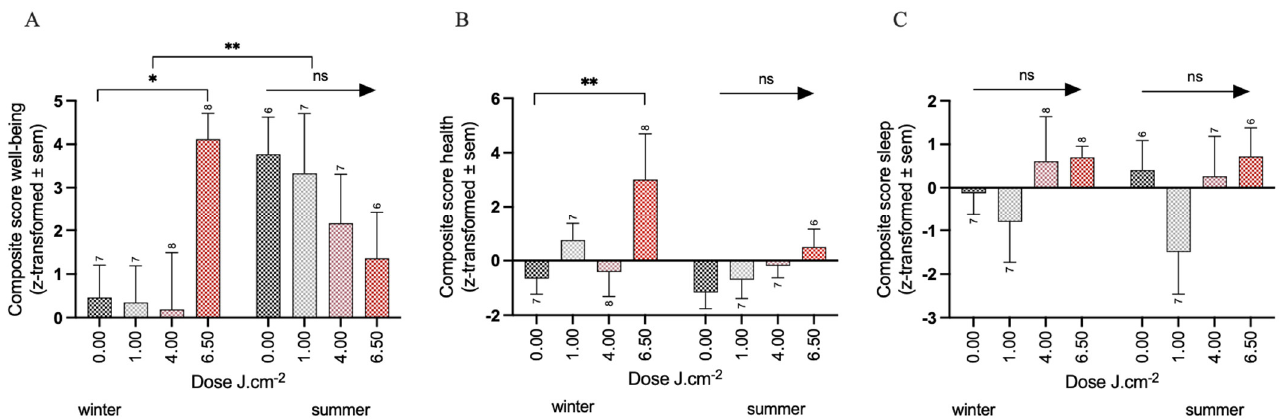
Figure 3. Change in composite score for winter and summer separately (average of the difference between week 2 and baseline and of week 4 and baseline) for ( A ) well-being, ( B ) health, and ( C ) sleep. Significance codes: ** p < 0.01, * p < 0.05, ns: not significant. Sample sizes per condition are shown.